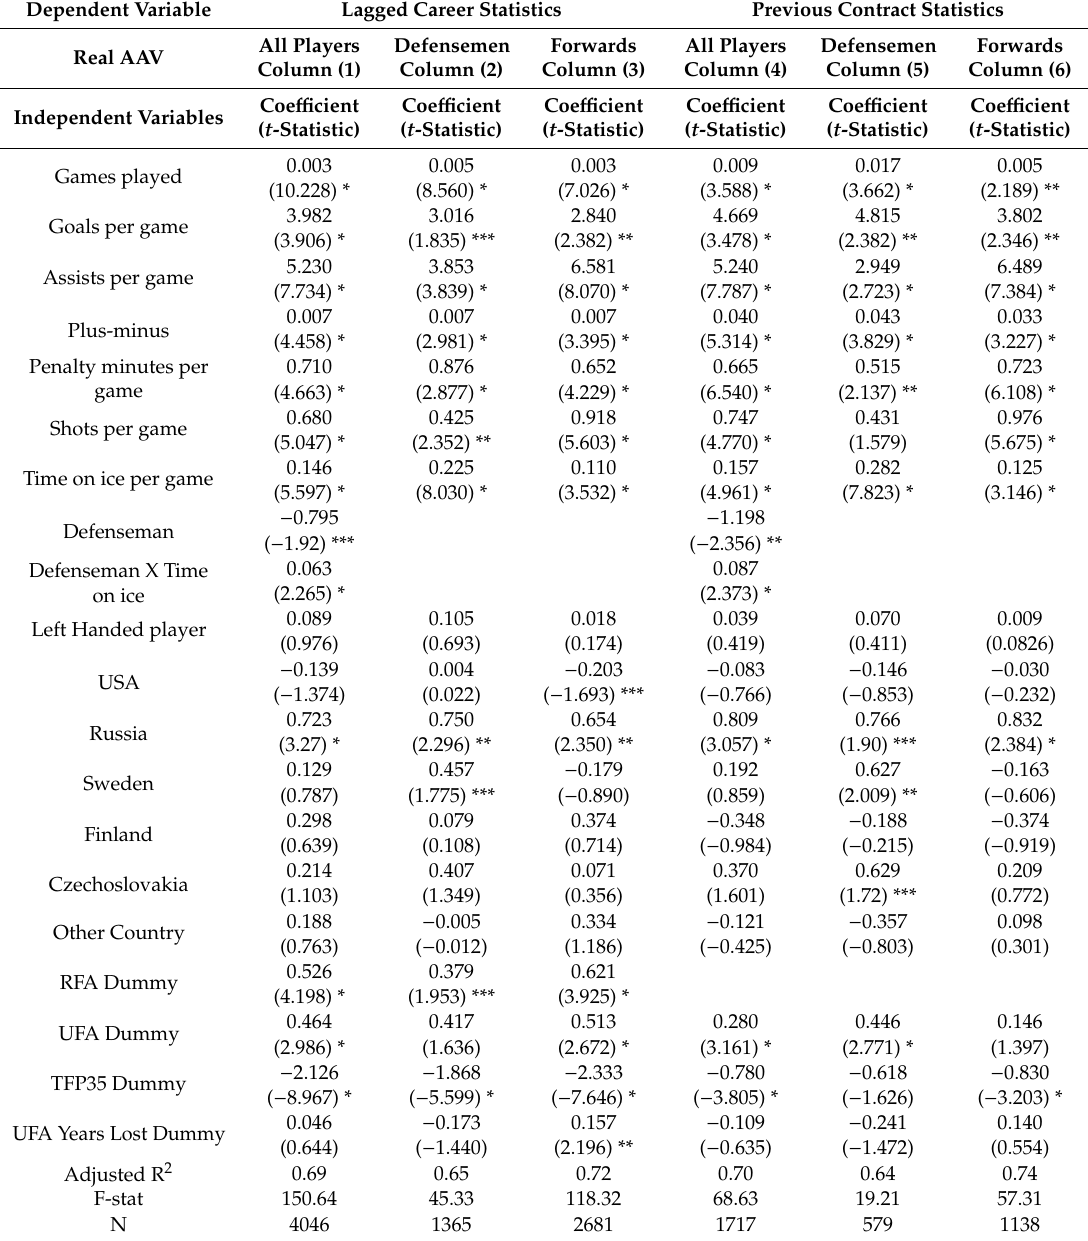
Table 2. Fixed e ff ects ordinary least squares (FELS) regression